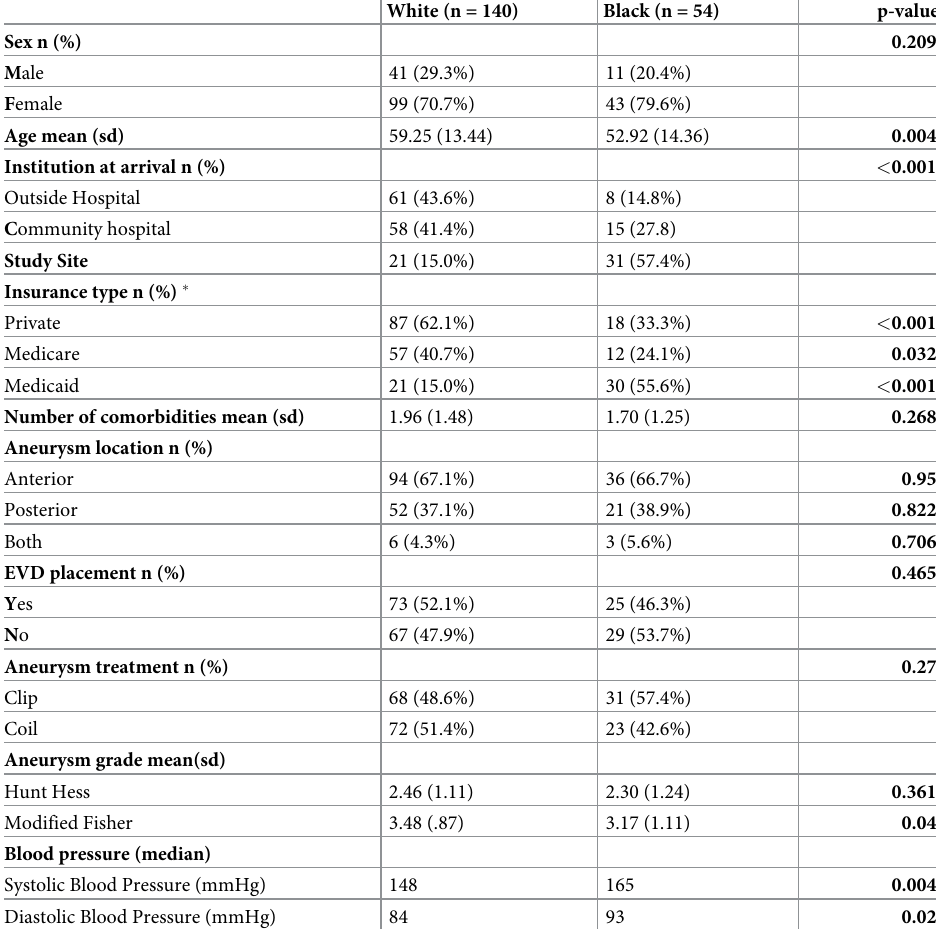
Table 1. Demographics and presentation of included